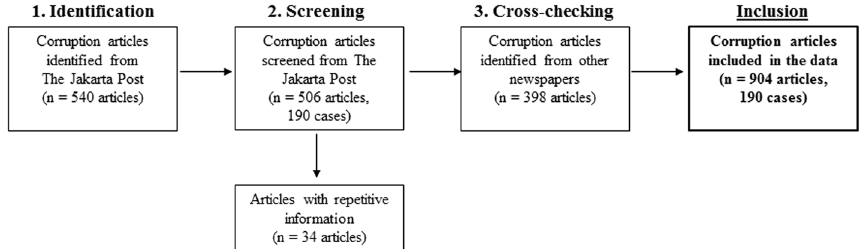
Fig. 1 Corruption articles selection